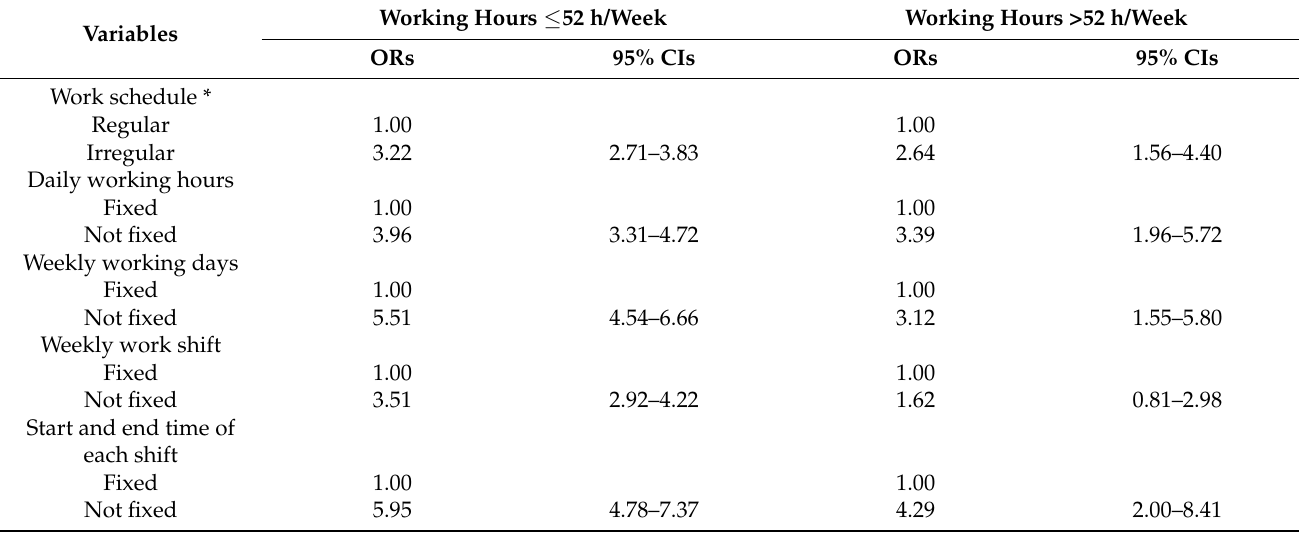
Table 5. Odds ratios and 95% confidence intervals for severe sleep disturbance based on working hour stratification